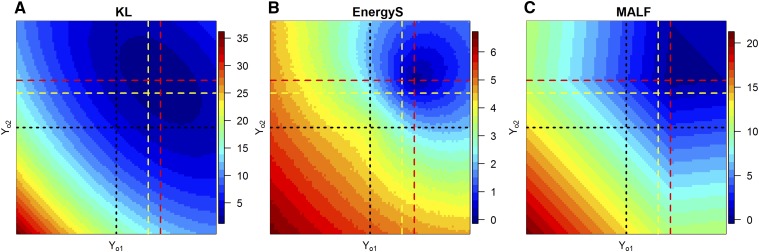
Bivariate representation of multivariate loss functions. A) Kullback-Leibler (KL), B) Energy Score (EnergyS), and C) Multivariate Asymmetric Loss Function (MALF). The base population is N2(μ, P), where μ=c(0,0)’ (black lines) and P=[2−1−12]. After truncation at y0=(1.3, 1.3)’ (yellow lines), the theoretical or desired mean of selected candidates is μs=(1.79, 1.79)’ (red lines). The candidates close to the region where each loss function is minimized will have minimum loss under the breeder’s preferences; those lines are the ones to advance in a selection program.